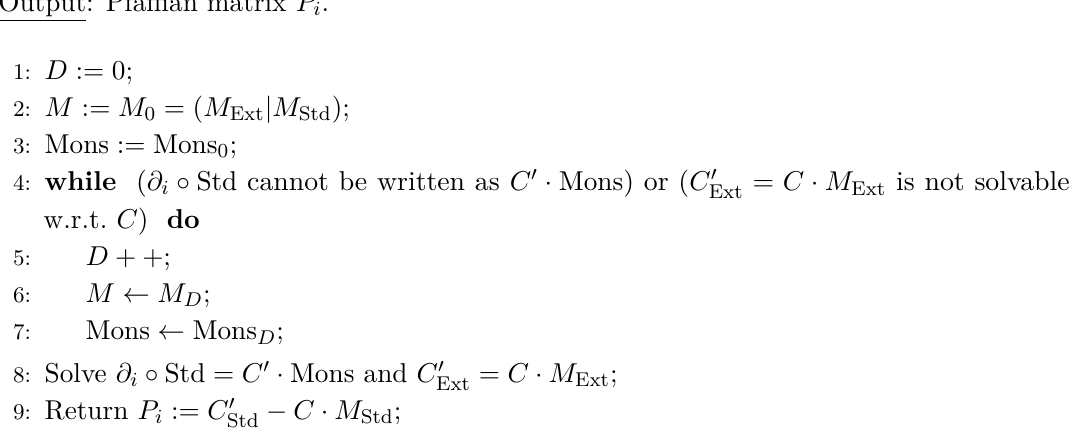
Algorithm 1 : Pfaffian matrix by Macaulay matrix method Input: Standard monomials Std , generators h direction i